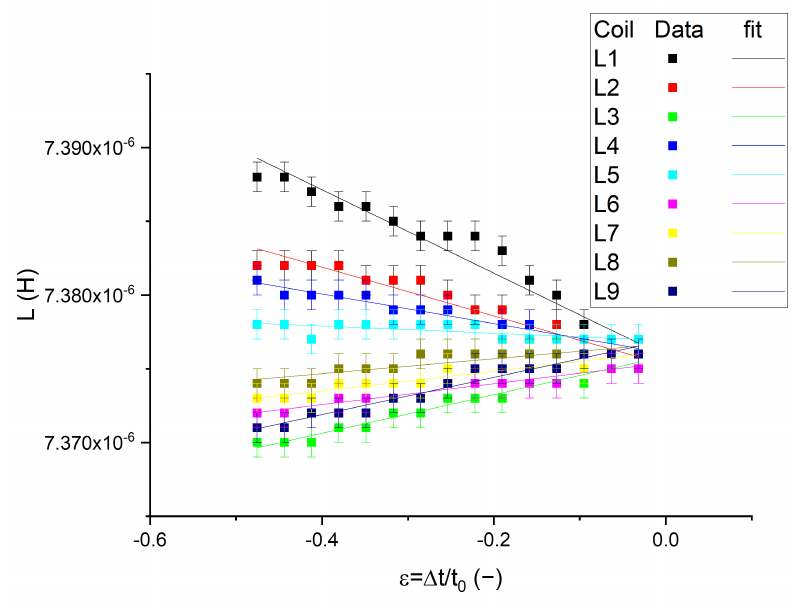
Figure 8. Coil inductance curves versus compression as the composite is deformed above L1.